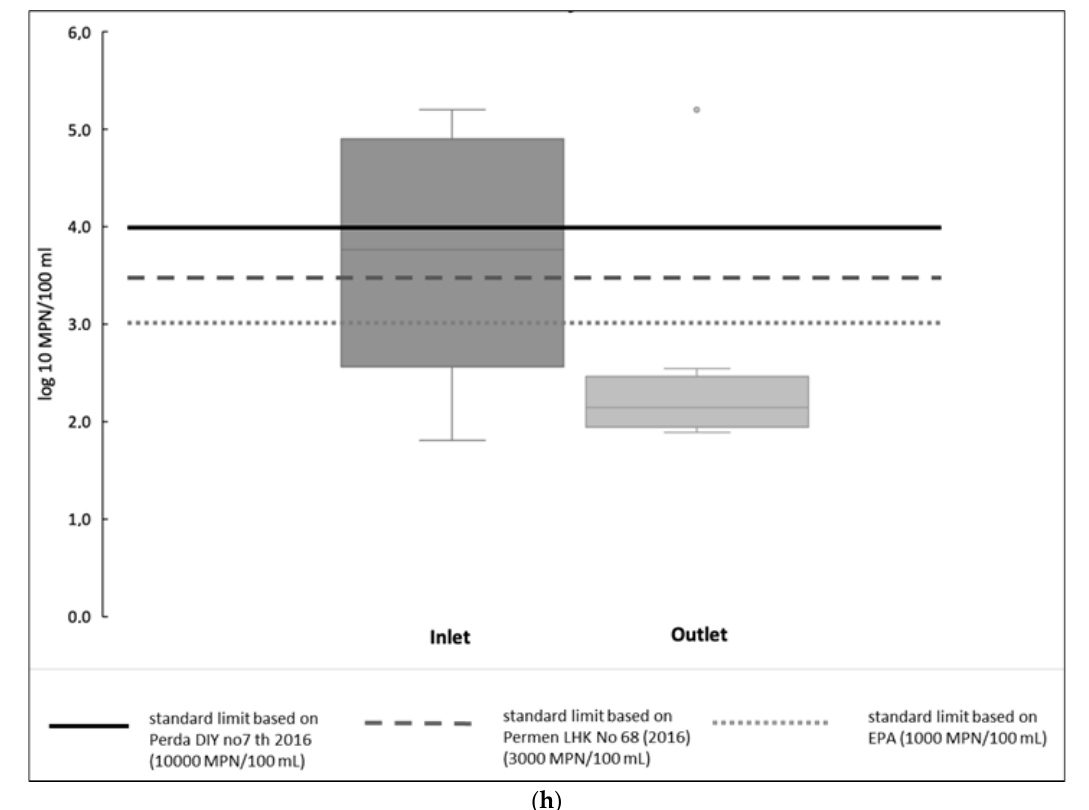
Figure 2. Comparison of ( a ) pH, ( b ) temperature, ( c ) TSS, ( d ) BOD, ( e ) COD, ( f ) ammonia, ( g ) oil and grease, ( h ) the average of total coliform from six CWWTPs at the inlet and outlet.